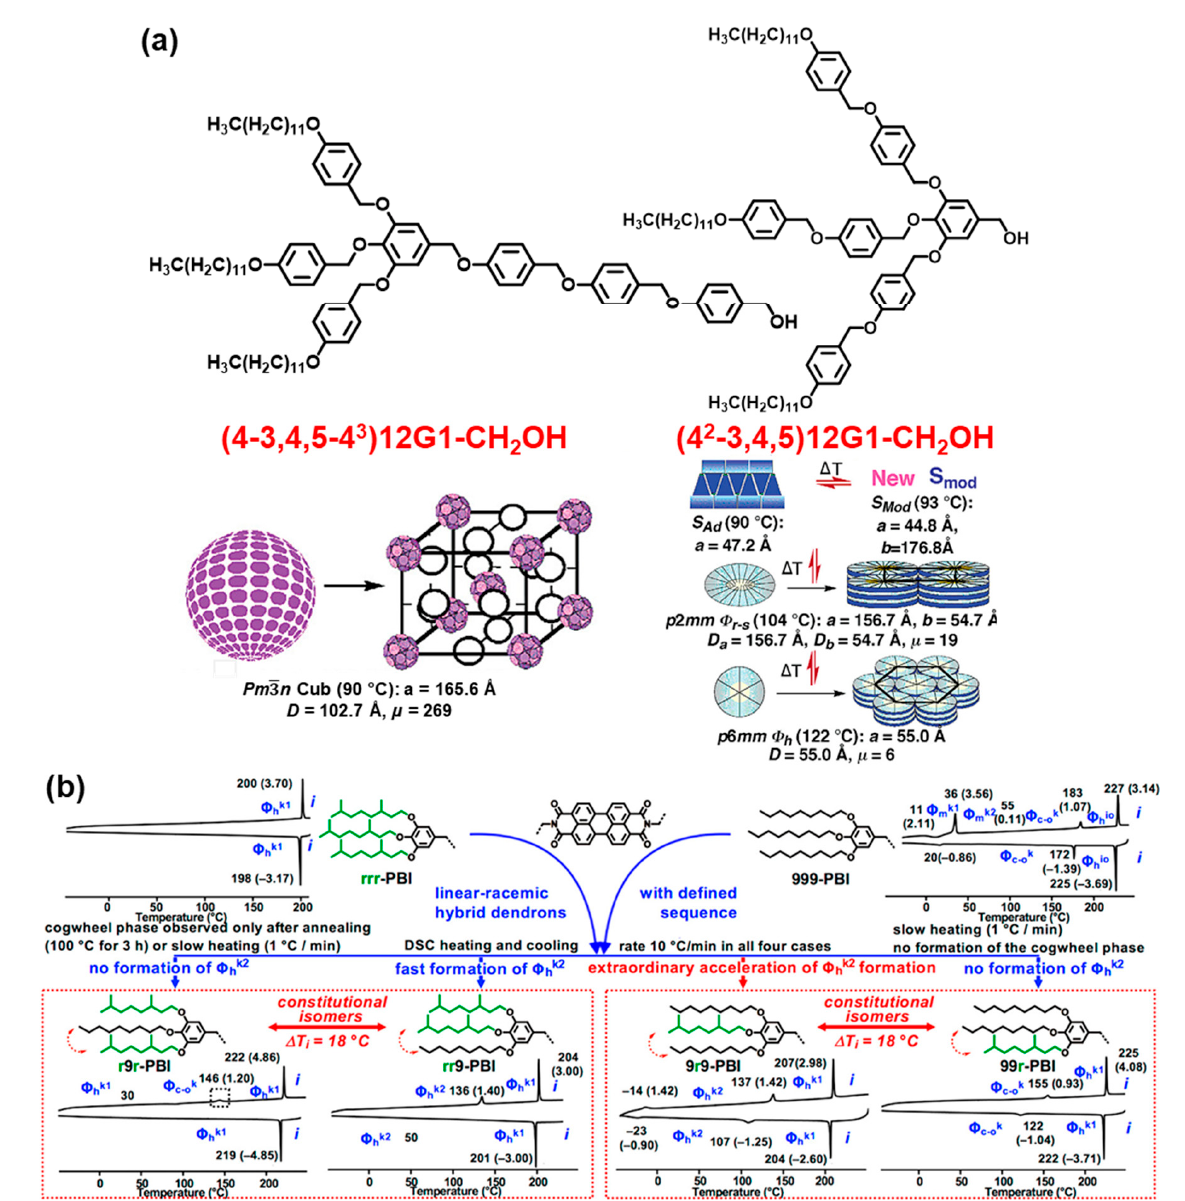
Figure 8. ( a ) Dendrons with identical chemical composition but different sequence forming different kinds of supramolecular structures. Supramolecular dendrimers self-assembled from (4-3,4,5-4 3 )12G1- CH 2 OH and (4 2 -3,4,5)12G1-CH 2 OH. ( b ) An example in which constitutional isomeric structures with identical composition but a different sequence of a combination of linear n -nonyl and branched chiral or racemic groups provide different supramolecular assemblies with different rates of heating and cooling. DSC traces of PBIs with sequence-defined hybrid r/ n -nonyl dendrons were recorded upon second heating and first cooling at 10 ◦ C/min. Phases determined by fiber XRD, transition temperatures (in ◦ C), and associated enthalpy changes (in parentheses, in kcal/mol) are indicated. Phase notation: Φ hk1 , columnar hexagonal crystal with offset dimers; Φ hk2 , columnar hexagonal crystal with cogwheel assembly; Φ c–ok , columnar centered orthorhombic crystal; Φ mk , columnar monoclinic crystal, i , isotropic liquid [127,140]. Parts of the Figure were adapted, combined, and modified from [127,140]. Copyright © 2004, American Chemical Society. Copyright © 2020, American Chemical